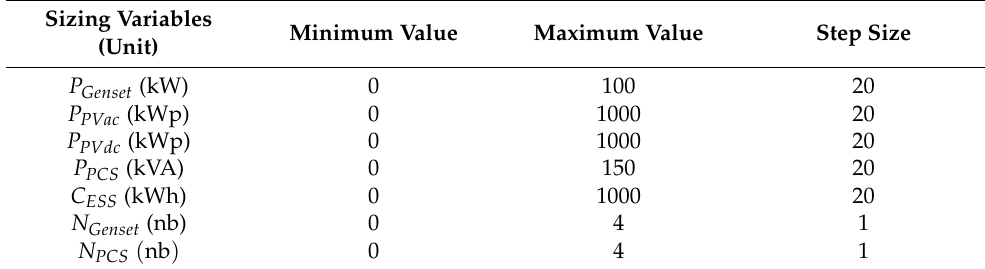
Table 3. Variable range of the genetic